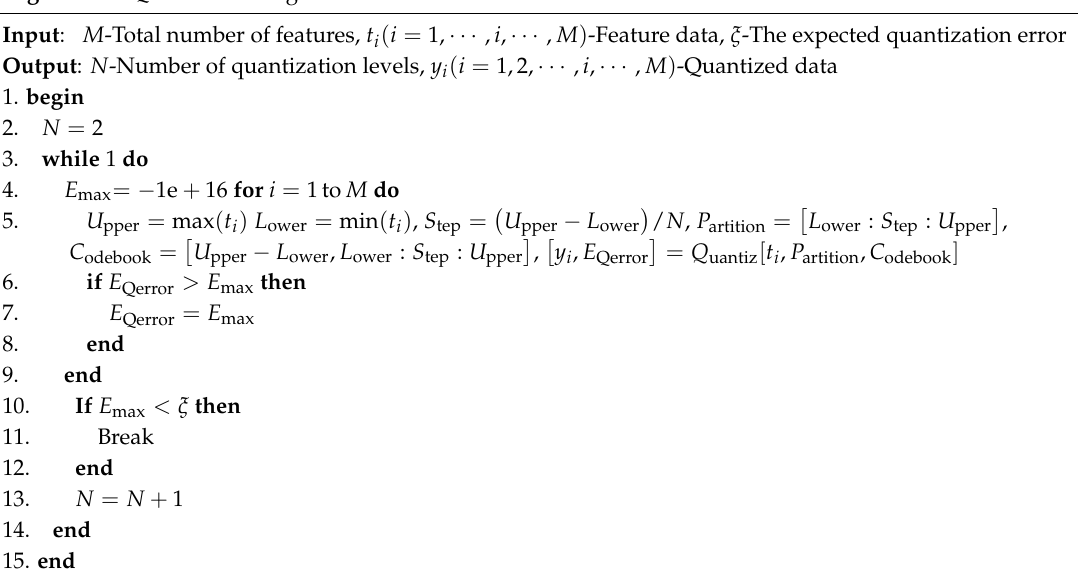
Algorithm 1 Quantization